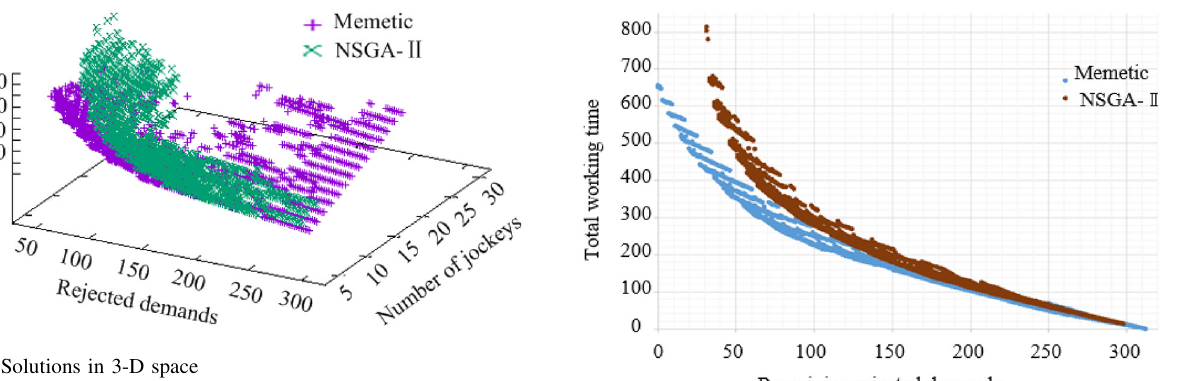
Fig. 6 Solutions in 3-D space